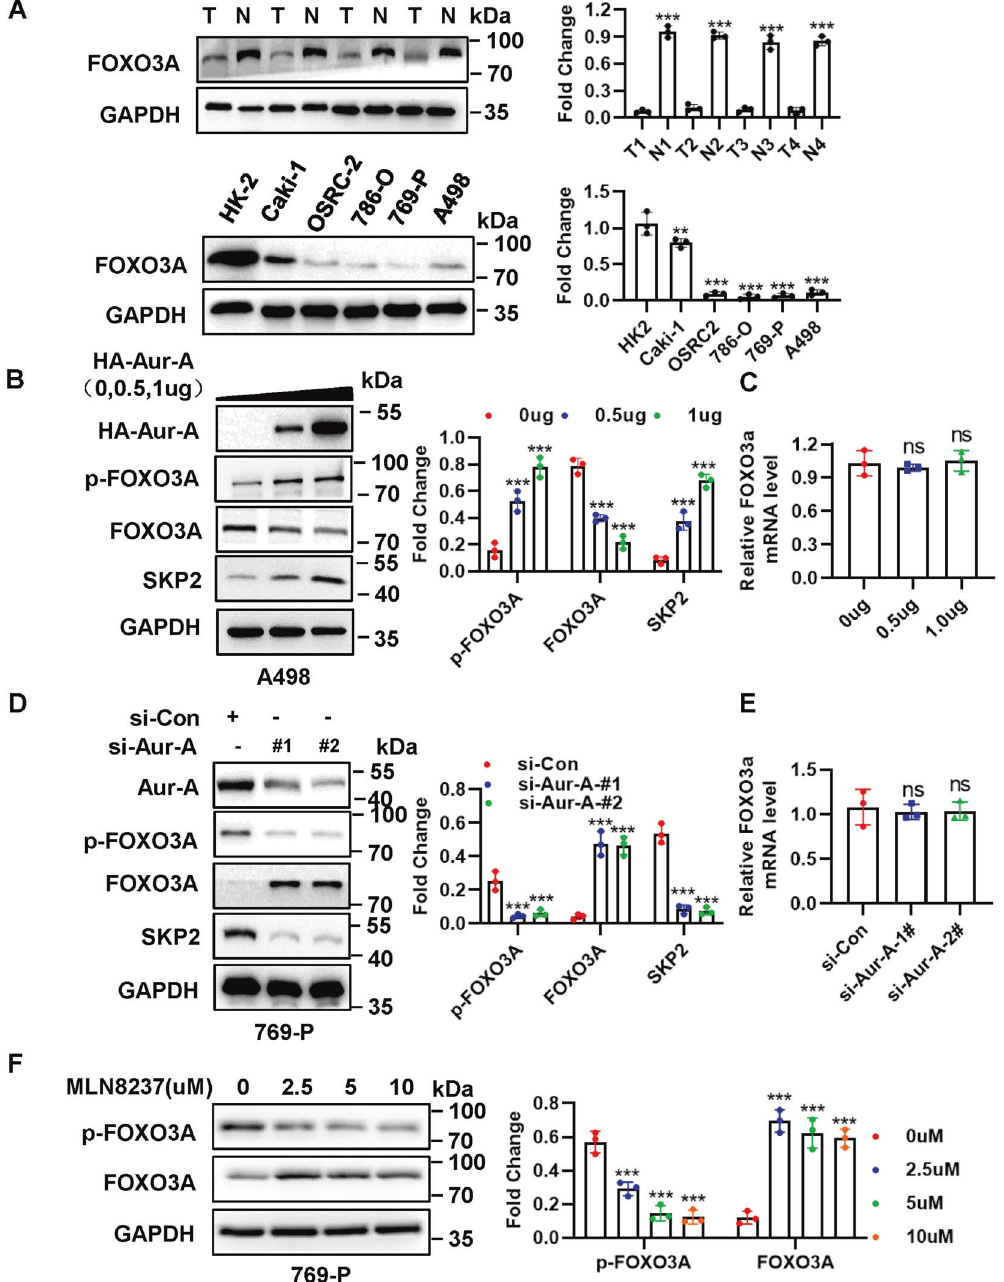
Fig. 4 Aur-A regulates SKP2 by mediating FOXO3A. A Basal level of Aur-A in ccRCC tissues (T) and normal adjacent tissues (N), and ccRCC cell lines. B , C Overexpression of Aur-A induced reduction of FOXO3A and increase of p-FOXO3A, but did not affect mRNA of FOXO3A. A498 cells were transfected with vector or HA-Aur-A (0, 0.5, 1 μ g), and followed by IB ( B ) and qPCR C analysis, respectively. D , E silencing of Aur-A increased FOXO3A and decreased p-FOXO3A, but did not affect mRNA of FOXO3A. 769-P cells were transfected siRNAs targeting Aur-A (siRNA- Aur-A-1# and siRNA-Aur-A-2#), and followed by IB ( D ) and qPCR E analysis, respectively. F Aur-A inhibitor MLN8237 decreased FOXO3A protein and increased p-FOXO3A protein in ccRCC cells. 769-P cells were incubated with indicated doses of MLN8237 (0, 2.5, 5, and 10 μ M) for 48 h, followed by IB analysis. The protein levels were normalized to GAPDH. ns no signi fi cance; ** p < 0.01, *** p < 0.001; n = 3 independent experiments; two-tailed paired Student ’ s t test or one-way ANOVA with Dunnett ’ s